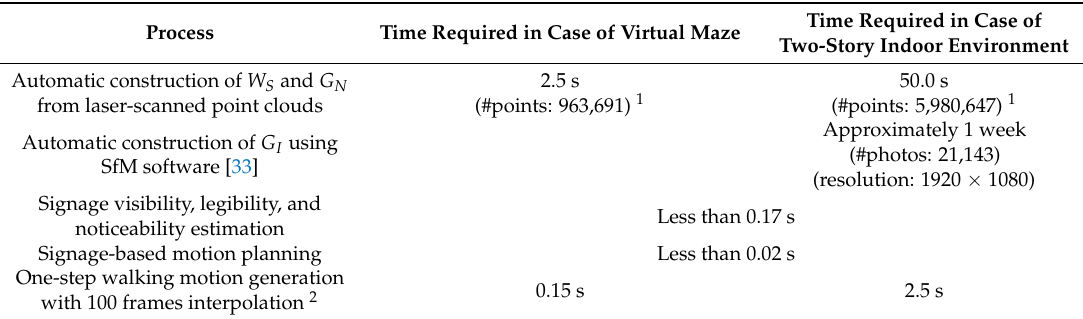
Table 6. Time required for environment modeling and simulation. (CPU: Intel(R) Core(TM) i7-6850K 3.60 GHz, RAM: 64 GB, GPU: GeForce GTX